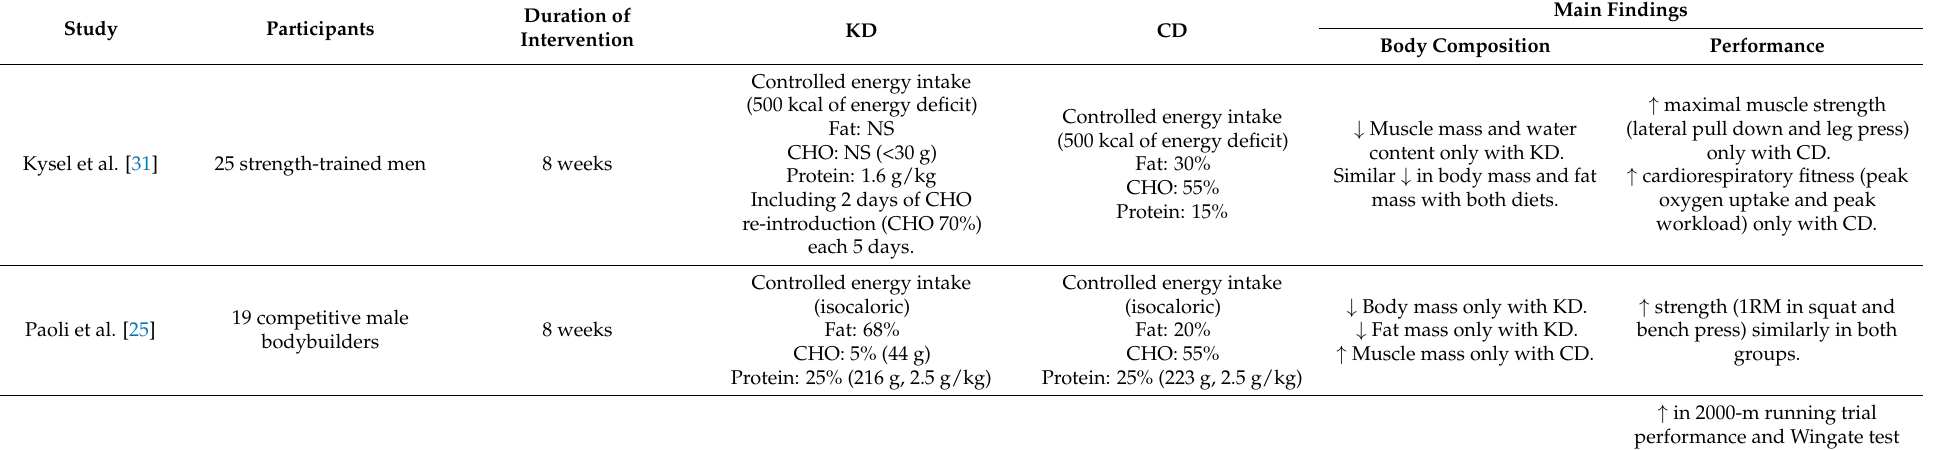
Table 1. Summary of randomized controlled trials that have assessed the effects of ketogenic diets (KD) on body composition or performance in healthy strength-trained individuals.